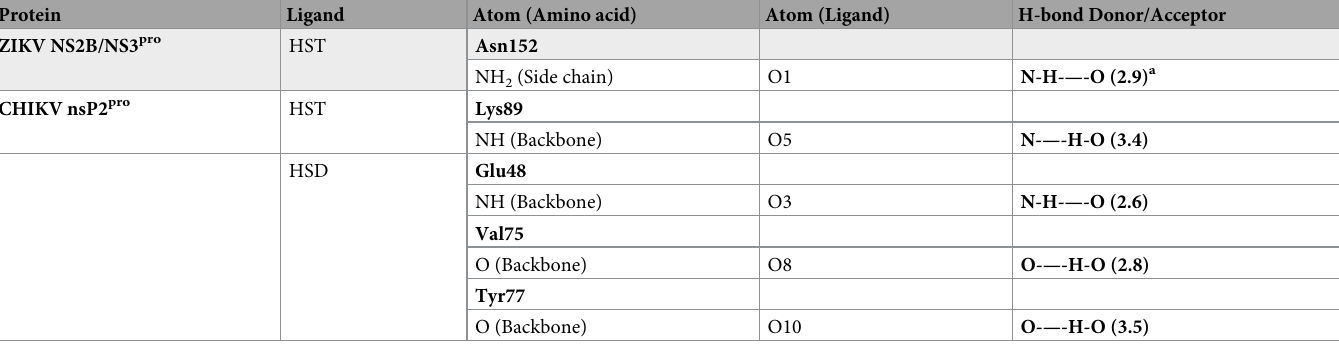
Table 4. Atoms involved in the H-Bond interaction between flavivirus and alphavirus proteases and ligands.